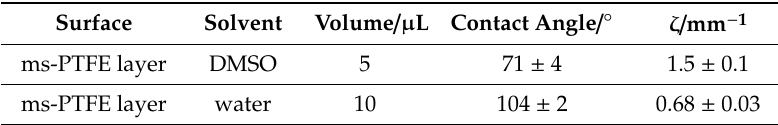
Table 2. Geometric parameters of the measured